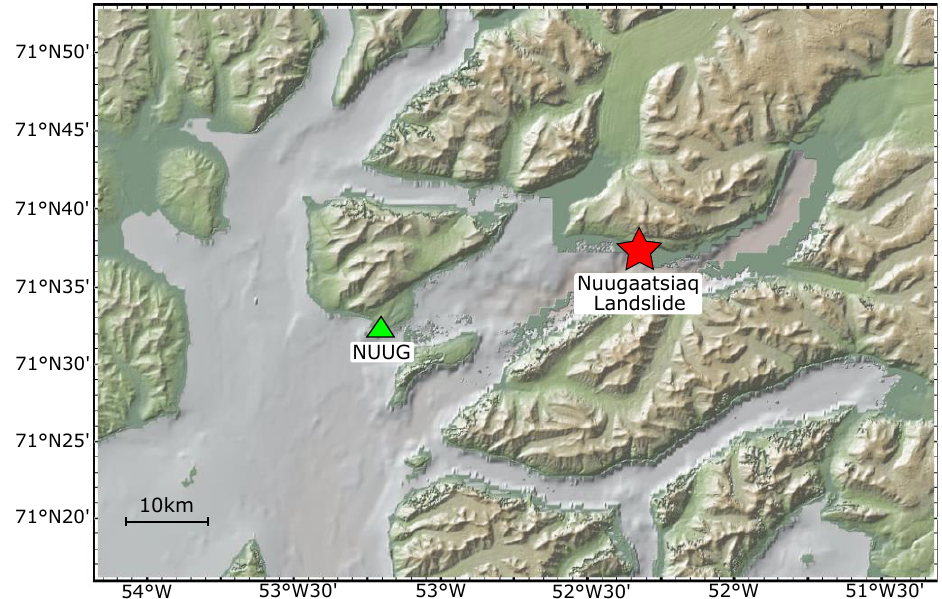
Figure 1. Map of our study area . Red star and lime triangle mark the Nuugaatsiaq landslide and seismic station NUUG, respectively.